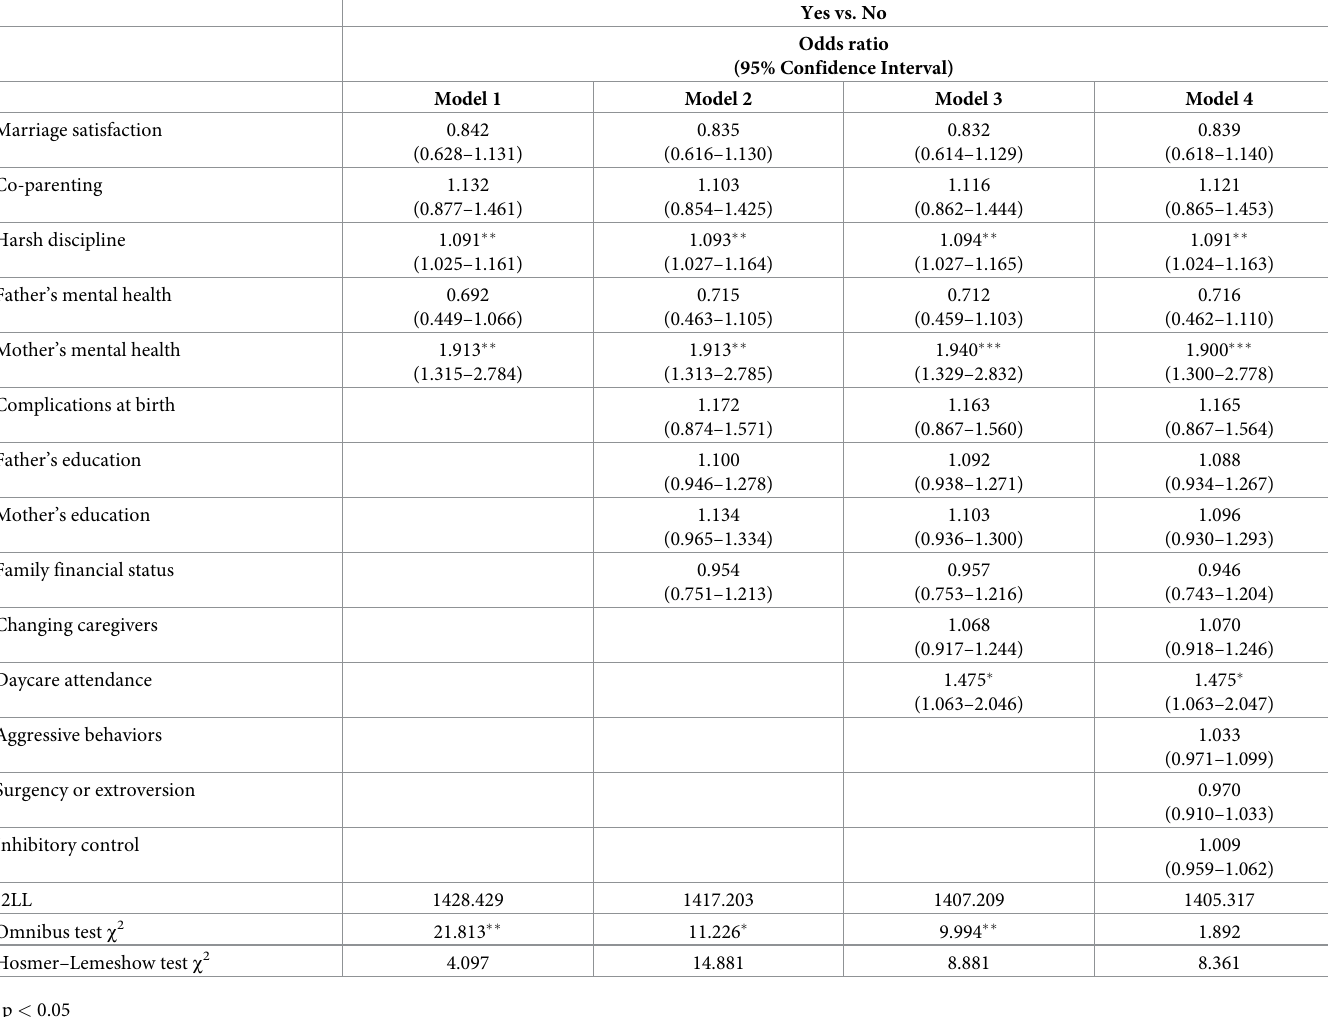
Table 4. Hierarchical logistic regression analysis for otitis media